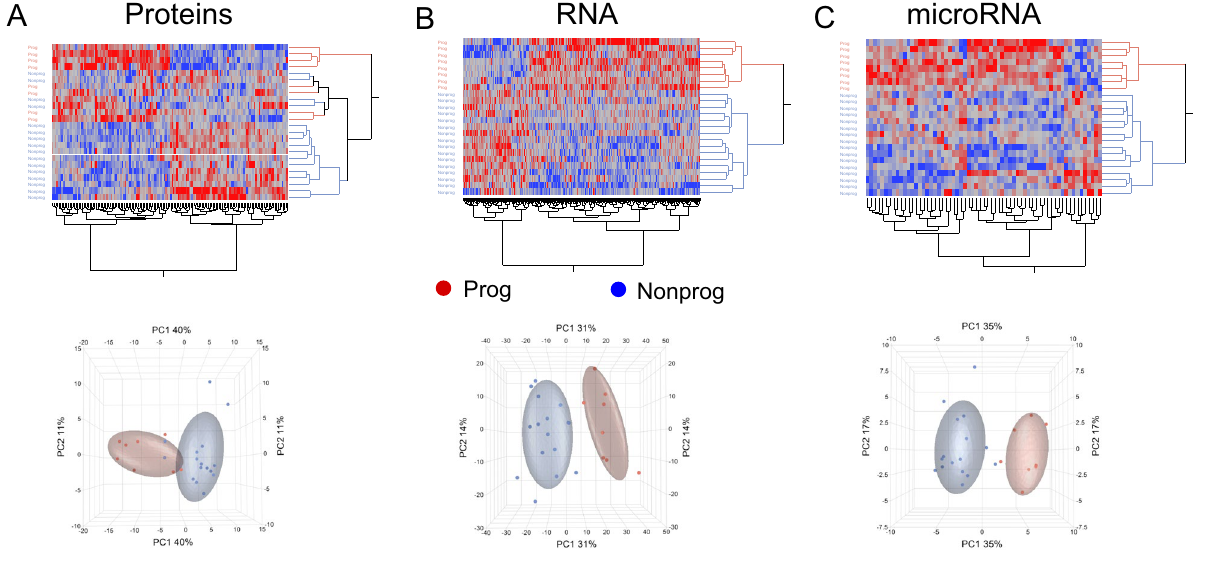
Figure 1. Hierarchical clustering analyses and principal component analyses (PCA). Hierarchical clustering of emerging data results in effective separation of patients’ groups. However, an overlap is still visible in the PCA